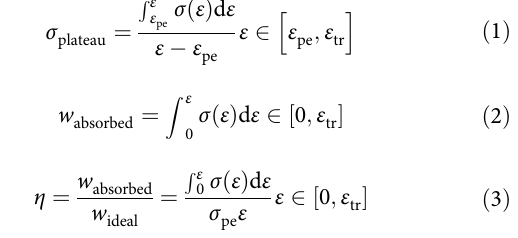
The plateau stress is an approximation of average stress in the second buckling stage ranging from the peak force strain ε pe to a given strain value in this regime. The absorbed energy is denoted by an integral area below the stress – strain curve at the given strain range (the hatched area in Fig. 2a). The ideal situation of absorbed energy is de fi ned as the integration of the constant peak stress for a given strain range (the gray area in Fig. 2a), and the ef fi ciency is the ratio of absorbed energy to the ideal energy.